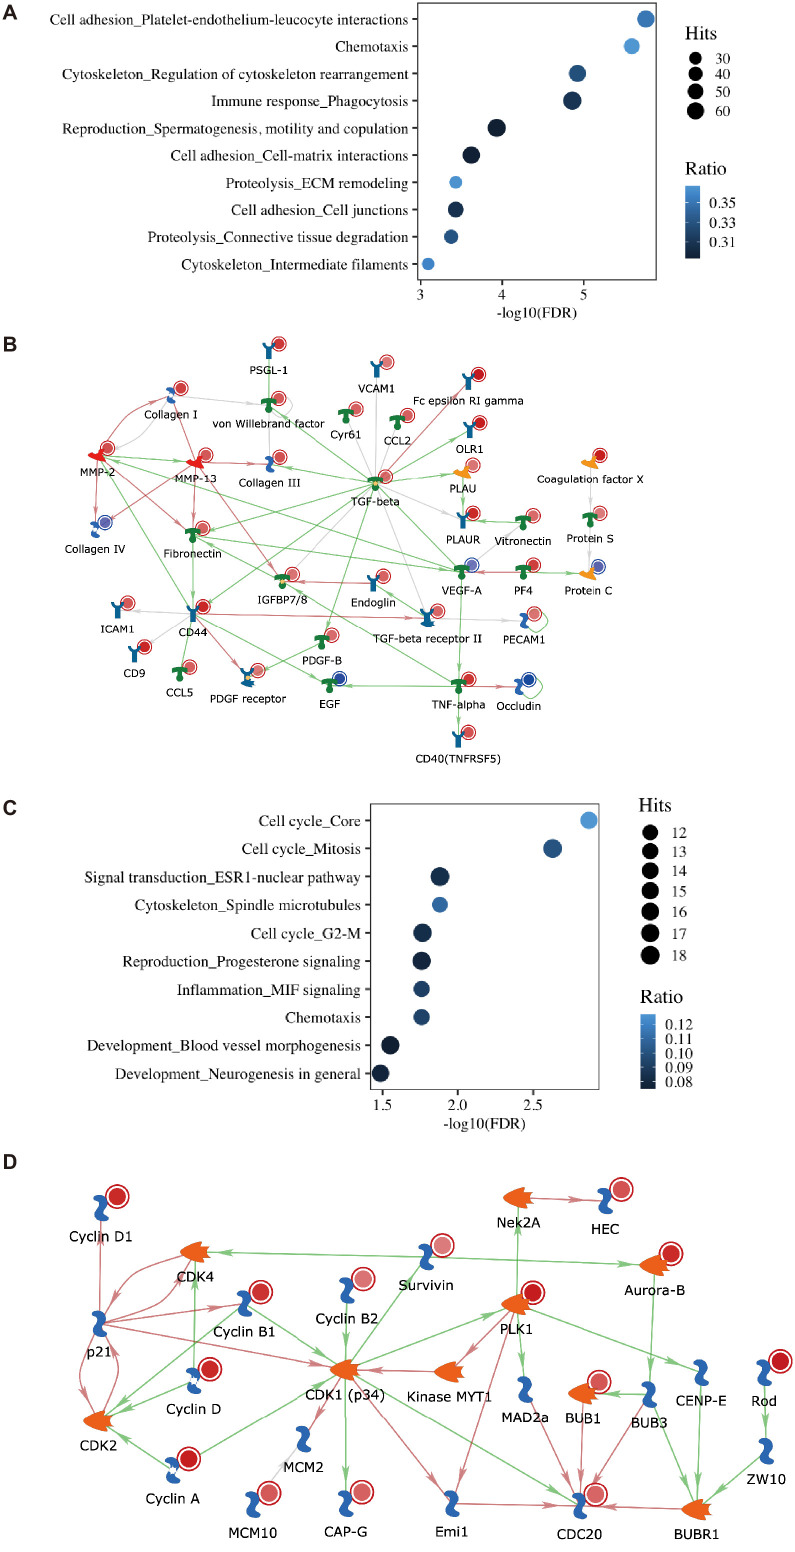
Gene set enrichment analyses of eWAT from MiR181a2b2 flex and KO mice.